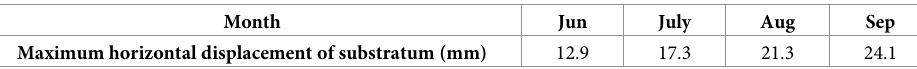
Table 7. Maximum cumulative displacement of the substratum of the Section K58 + 950 (Depth =